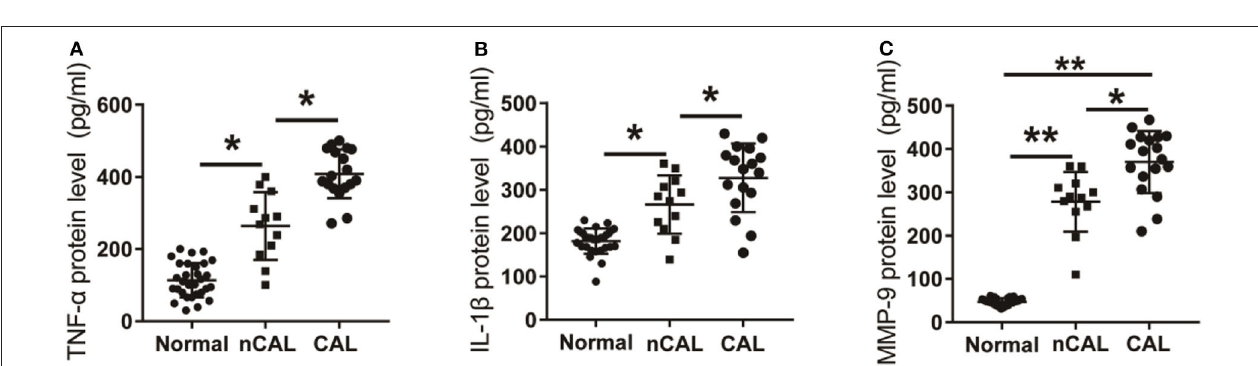
FIGURE 6 | Expression of inflammatory factors in KD patients and control group. (A) TNF- α protein level in KD patients was detected by Elisa. (B) IL-1 β protein level in KD patients. (C) MMP-9 protein level in KD patients. * P < 0.05; ** P < 0.01.